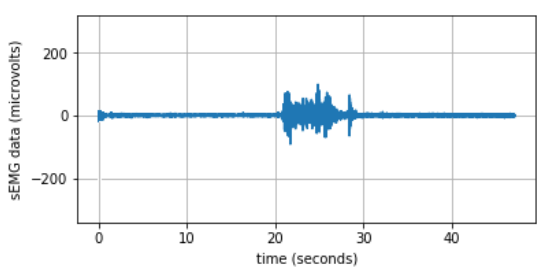
Figure 4. Electrode placement.